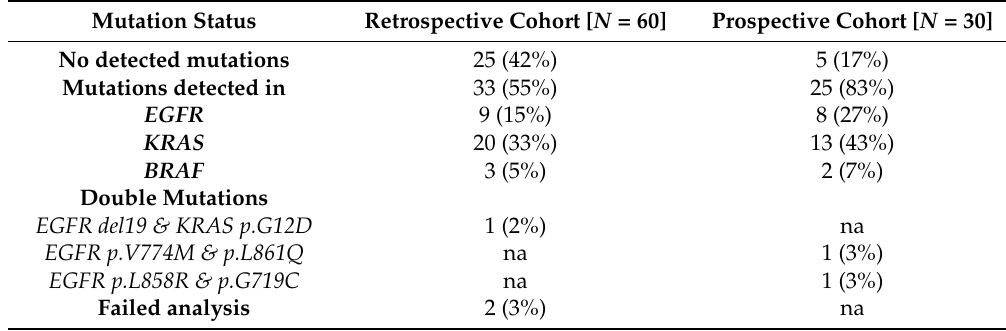
Table 2. Description of the mutational status of the 90 patients with advanced non-small cell lung cancer included in the